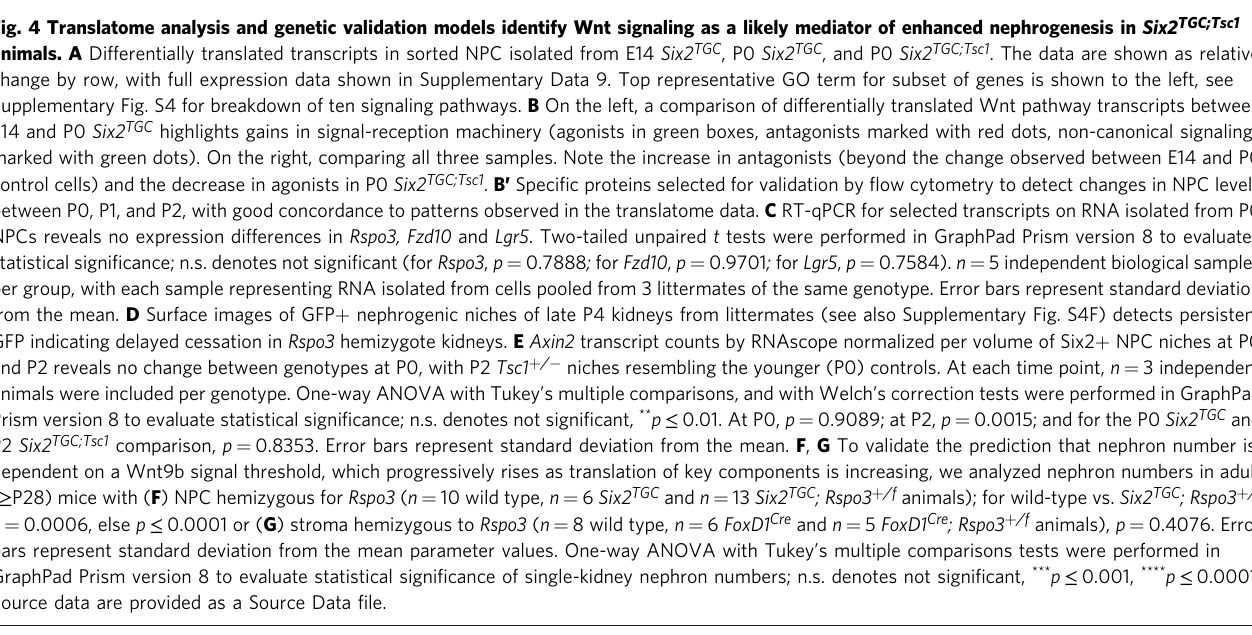
Fig. 4 Translatome analysis and genetic validation models identify Wnt signaling as a likely mediator of enhanced nephrogenesis in Six2 TGC;Tsc1 animals. A Differentially translated transcripts in sorted NPC isolated from E14 Six2 TGC , P0 Six2 TGC , and P0 Six2 TGC;Tsc1 . The data are shown as relative change by row, with full expression data shown in Supplementary Data 9. Top representative GO term for subset of genes is shown to the left, see Supplementary Fig. S4 for breakdown of ten signaling pathways. B On the left, a comparison of differentially translated Wnt pathway transcripts between E14 and P0 Six2 TGC highlights gains in signal-reception machinery (agonists in green boxes, antagonists marked with red dots, non-canonical signaling marked with green dots). On the right, comparing all three samples. Note the increase in antagonists (beyond the change observed between E14 and P0 control cells) and the decrease in agonists in P0 Six2 TGC;Tsc1 . B ’ Speci fi c proteins selected for validation by fl ow cytometry to detect changes in NPC levels between P0, P1, and P2, with good concordance to patterns observed in the translatome data. C RT-qPCR for selected transcripts on RNA isolated from P0 NPCs reveals no expression differences in Rspo3, Fzd10 and Lgr5 . Two-tailed unpaired t tests were performed in GraphPad Prism version 8 to evaluate statistical signi fi cance; n.s. denotes not signi fi cant (for Rspo3 , p = 0.7888 ; for Fzd10 , p = 0.9701 ; for Lgr5 , p = 0.7584). n = 5 independent biological samples per group, with each sample representing RNA isolated from cells pooled from 3 littermates of the same genotype. Error bars represent standard deviation from the mean. D Surface images of GFP + nephrogenic niches of late P4 kidneys from littermates (see also Supplementary Fig. S4F) detects persistent GFP indicating delayed cessation in Rspo3 hemizygote kidneys. E Axin2 transcript counts by RNAscope normalized per volume of Six2 + NPC niches at P0 and P2 reveals no change between genotypes at P0, with P2 Tsc1 + / − niches resembling the younger (P0) controls. At each time point, n = 3 independent animals were included per genotype. One-way ANOVA with Tukey ’ s multiple comparisons, and with Welch ’ s correction tests were performed in GraphPad Prism version 8 to evaluate statistical signi fi cance; n.s. denotes not signi fi cant, ** p ≤ 0.01. At P0, p = 0.9089; at P2, p = 0.0015; and for the P0 Six2 TGC and P2 Six2 TGC;Tsc1 comparison, p = 0.8353. Error bars represent standard deviation from the mean. F , G To validate the prediction that nephron number is dependent on a Wnt9b signal threshold, which progressively rises as translation of key components is increasing, we analyzed nephron numbers in adult ( ≥ P28) mice with ( F ) NPC hemizygous for Rspo3 ( n = 10 wild type, n = 6 Six2 TGC and n = 13 Six2 TGC ; Rspo3 + /f animals); for wild-type vs. Six2 TGC ; Rspo3 + /f p = 0.0006, else p ≤ 0.0001 or ( G ) stroma hemizygous to Rspo3 ( n = 8 wild type, n = 6 FoxD1 Cre and n = 5 FoxD1 Cre ; Rspo3 + /f animals), p = 0.4076. Error bars represent standard deviation from the mean parameter values. One-way ANOVA with Tukey ’ s multiple comparisons tests were performed in GraphPad Prism version 8 to evaluate statistical signi fi cance of single-kidney nephron numbers; n.s. denotes not signi fi cant, *** p ≤ 0.001, **** p ≤ 0.0001. Source data are provided as a Source Data fi